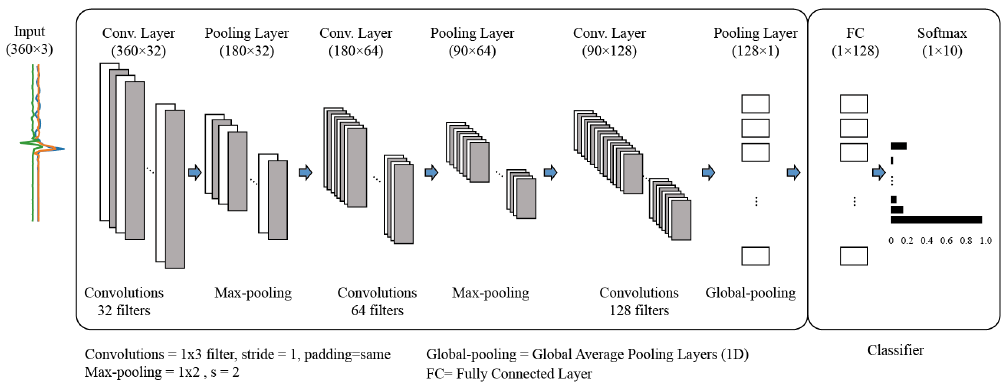
Figure 6. One-dimensional convolutional neural network (1D-CNN) models used in this study (for input data of 360 time steps, loading & unloading window). We used the same architecture for the input data of 100 time steps (loading and unloading windows); however, the input and output shapes were slightly different. Rectified linear function (ReLU) was used as activation function except for the output node that uses a softmax function.